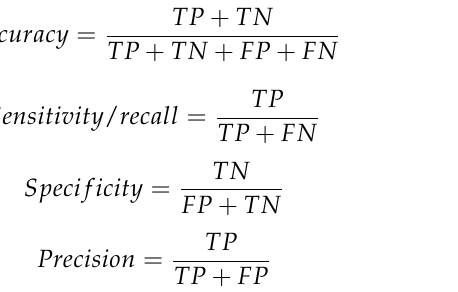
Supplementary Materials: The following are available online. Table S1: Abalone predicted anti-TIPs by kNN and RF-based